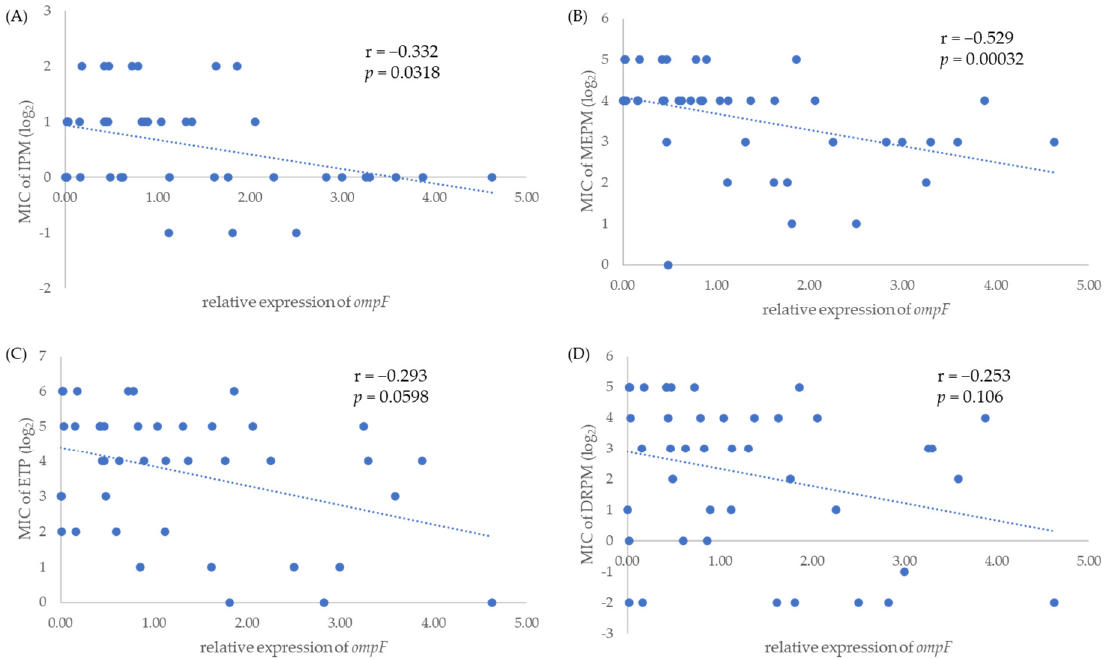
Figure 2. Correlation between relative expression levels of ompF and MICs of four carbapenems, IPM ( A ), MEPM ( B ), ETP ( C ), and DRPM ( D ), among IMP-6-producing E. coli strains.